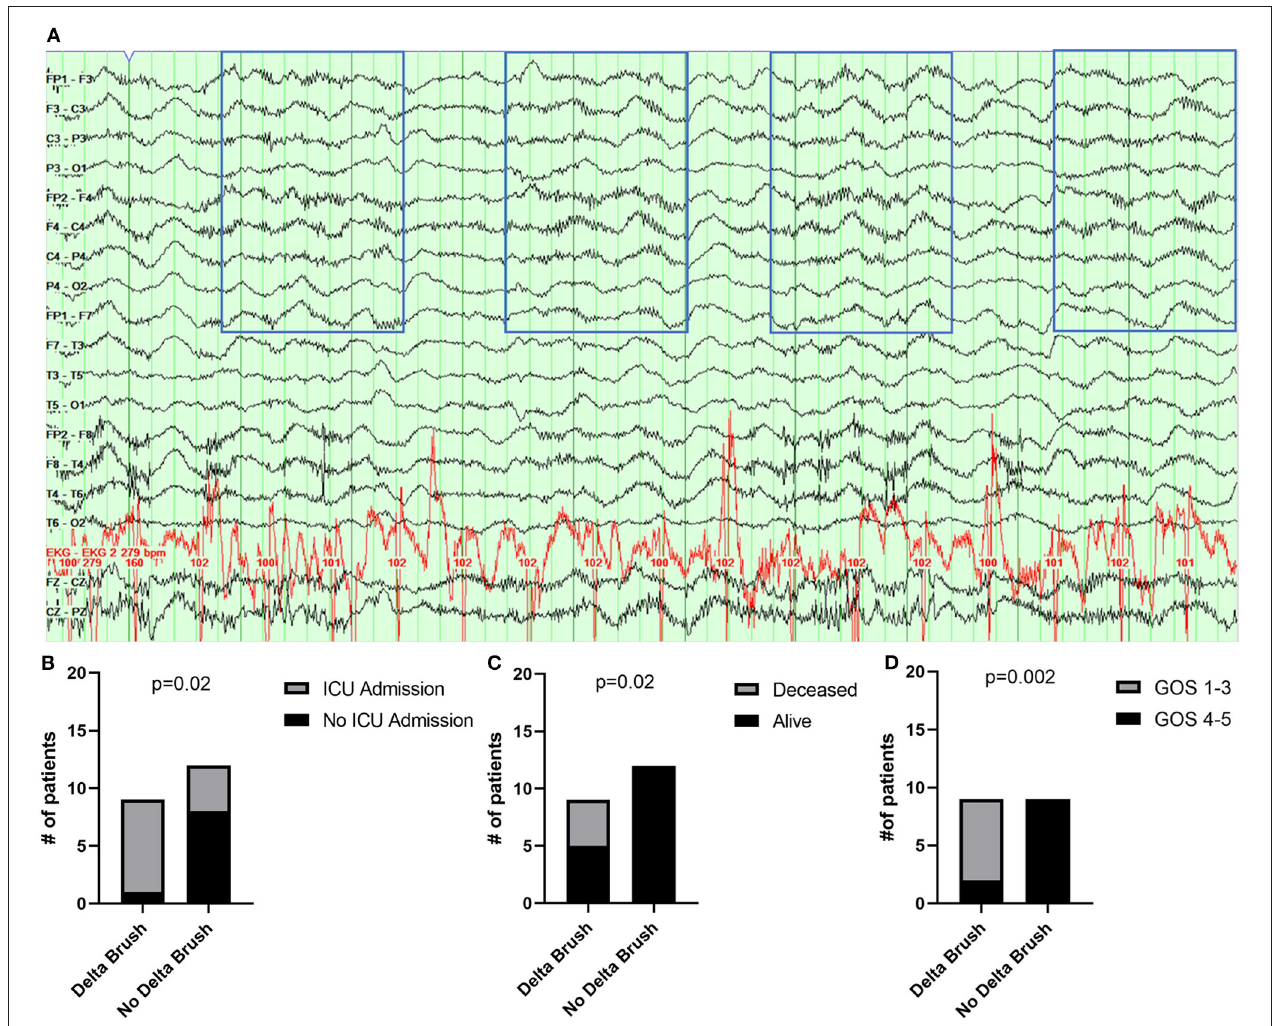
FIGURE 1 | Association between extreme delta brush and need for ICU admission, death, and functional outcome. (A) Extreme delta brush (EDB) is seen (outlined by blue boxes) on this bipolar montage EEG in a patient with anti-NMDAR encephalitis. (B) Association between EDB and need for ICU admission. (C) Association between EDB and status (alive vs. deceased). (D) Association between EDB and GOS score at 6 months (score of 1–3 indicative of poor outcome, score of 4–5 indicative of good outcome).